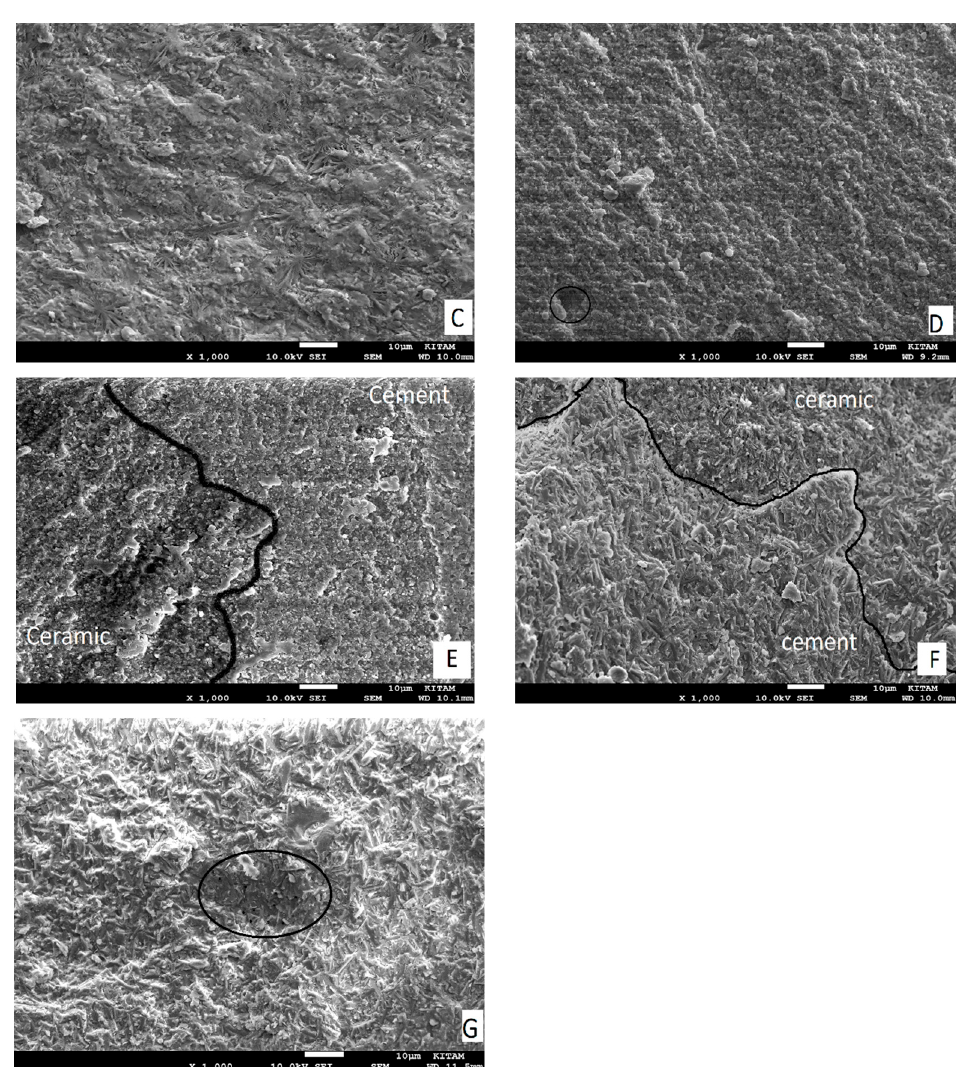
Figure 1. SEM micrographs of failure modes and the ceramic surface after treatment in a representa- tive specimen: ( A ) Group S: adhesive failure (mode 1), where no trace of other substrate was found on the surface. ( B ) Group SC: adhesive failure (mode 4), where failure starts at the ceramic–adhesive interface as a corner flaw (lower left) and propagates through the adhesive resin. ( C ) Group ALS: adhesive failure (mode 5), where trace or other substrate was found on the surface. ( D ) Group SHT1) adhesive failure (Mode 2), the semicircular flaw is the crack origin; the adhesive resin is in the middle of the fracture surface. ( E ) Group SHT2: mixed failure mode, in a representative sample; lithium disilicate crystals are scarcely evident on the uncovered ceramic surface. ( F ) Group HF: mixed failure mode in a representative sample; the ceramic surface (black area) is partly covered with cement (white area), ceramic crystals are visible following the removal of the glassy phase. ( G ) Group SHF: adhesive failure (Mode 3), where the internal defect is the origin of the crack (black circle), the cement in the center of the fracture surface representing what qualifies as a failure.